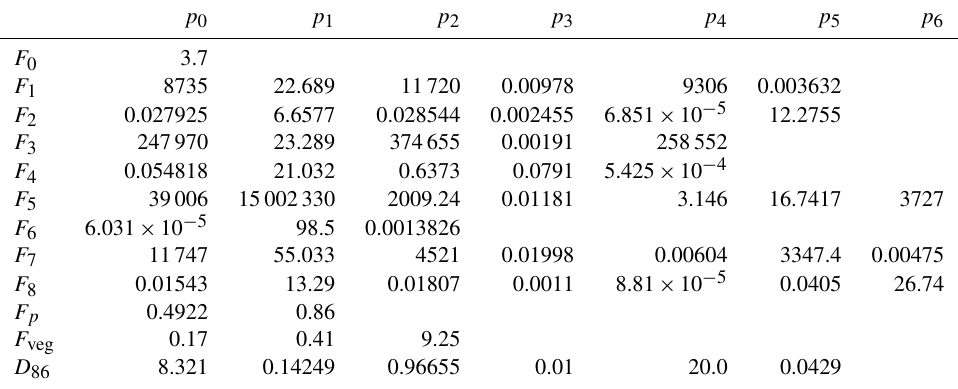
Table A1. Parameters for the horizontal weighting function, the adapted distance scaling, and the effective penetration depth (Appendix A). p